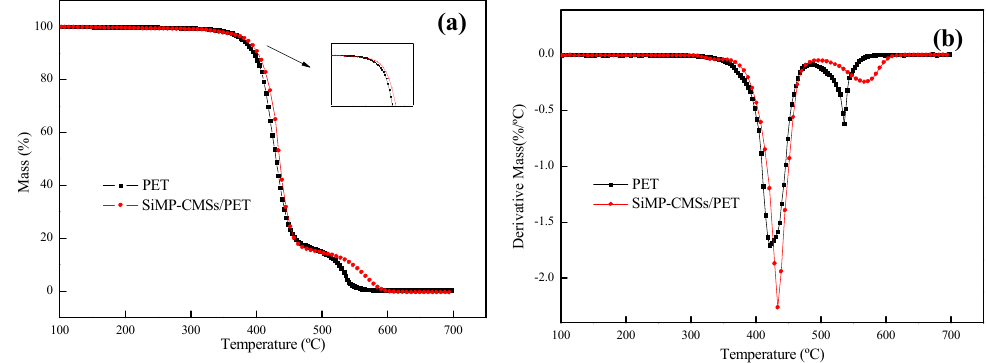
Figure 8. TGA ( a ) and DTG ( b ) curves of the SiMP-CMSs/PET composites in the air atmosphere. Table 5. Thermal stability and degradation of the SiMP-CMSs/PET composites.